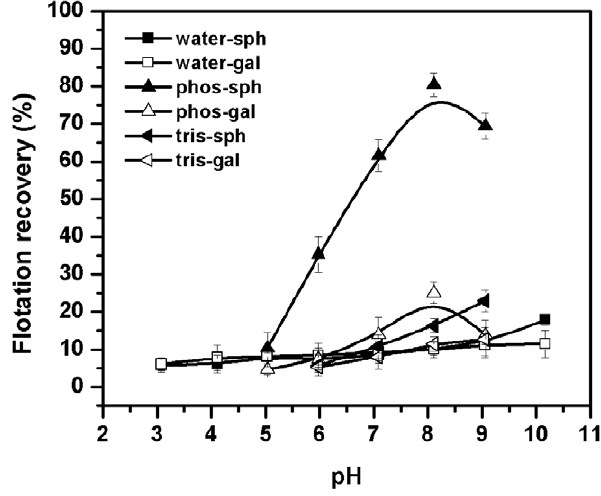
Figure 1. Effect of buffering of cells on the flotation recovery of sphalerite and galena.